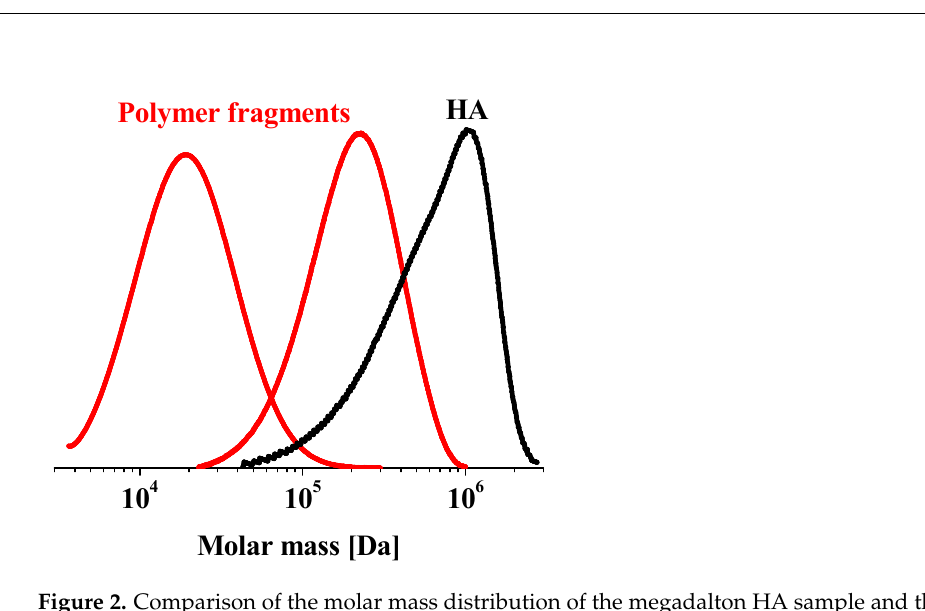
Figure 2. Comparison of the molar mass distribution of the megadalton HA sample and those ones degraded in situ under aerobic condition by action of AscH − and copper ions. Adapted from [51], published by Elsevier, 2007.